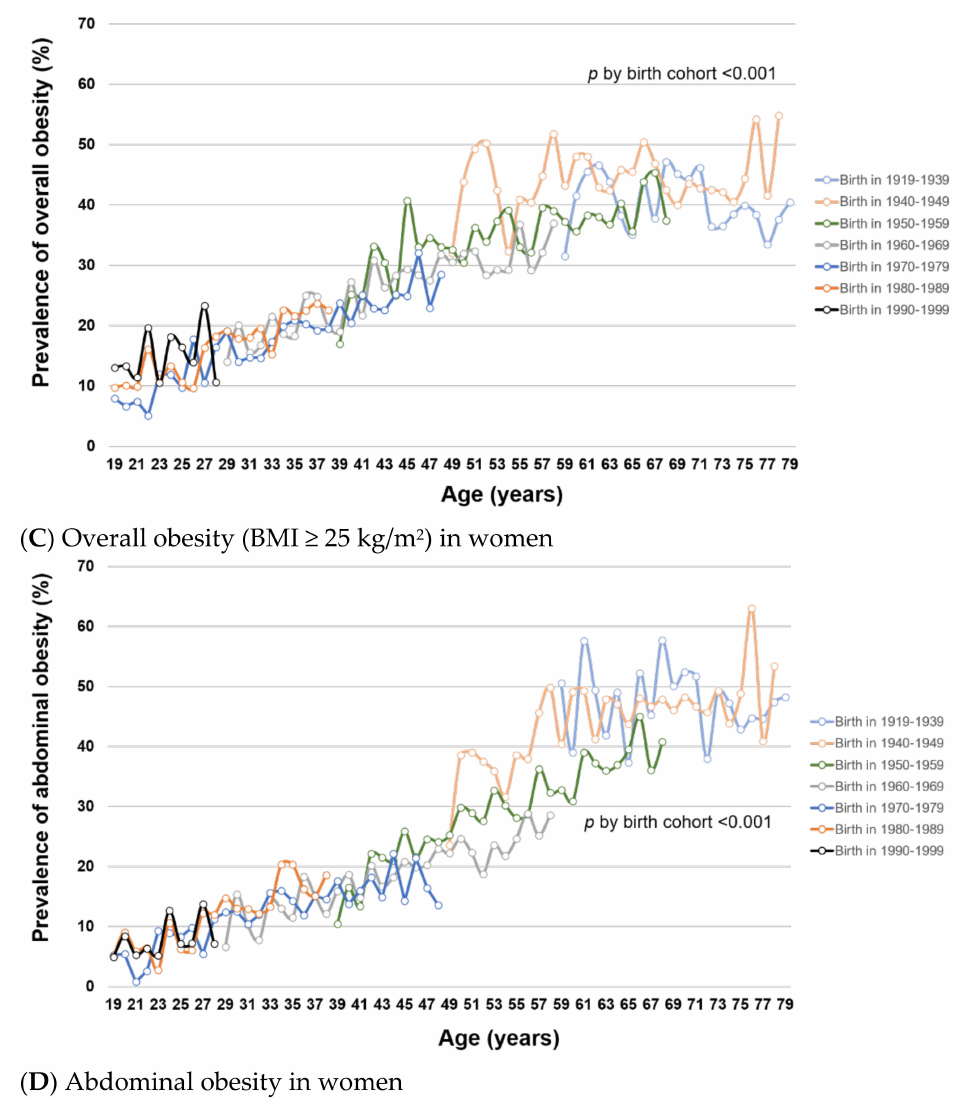
Figure 2. ( A – D ). Trends of overall and abdominal obesity prevalence by birth cohort and age in Korean men and women from KNHANES I (1998) to VII (2016–2018). This figure shows the age- specific prevalence of ( A ) overall obesity (BMI ≥ 25 kg/m 2 ) in men, ( B ) abdominal obesity in men, ( C ) overall obesity (BMI ≥ 25 kg/m 2 ) in women, and ( D ) abdominal obesity in women by birth cohort in KNHANES I–VII. Tests for difference by birth cohorts were performed using global F tests for categorical variable of birth